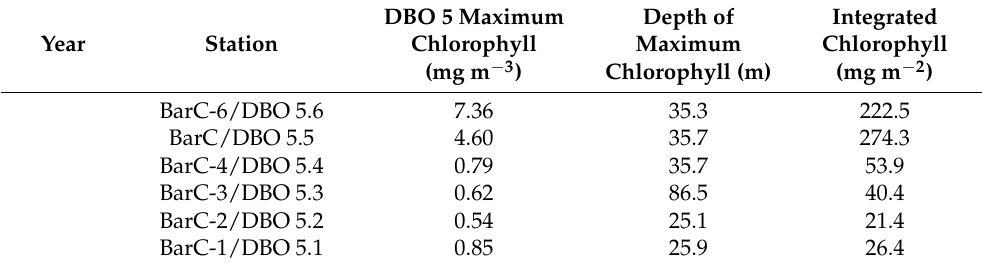
Figure 3. Correlations between integrated chlorophyll over whole water column relative to maxi- mum chlorophyll observed at any specific depth. 3.7. Chlorophyll-a Concentrations from October 2020 Cruise The observations of chlorophyll-a in the water column during the October 2020 cruise vary from the annual July observations. Overall, integrated chlorophyll-a in October 2020 (Figure 4) was not as high as the example from July 2018 (Figure 5). However, some sta- tions in October, particularly in shallow water (<40 m) such as UTN1 and on the eastern side of the Bering Strait, had higher integrated chlorophyll-a than in July.